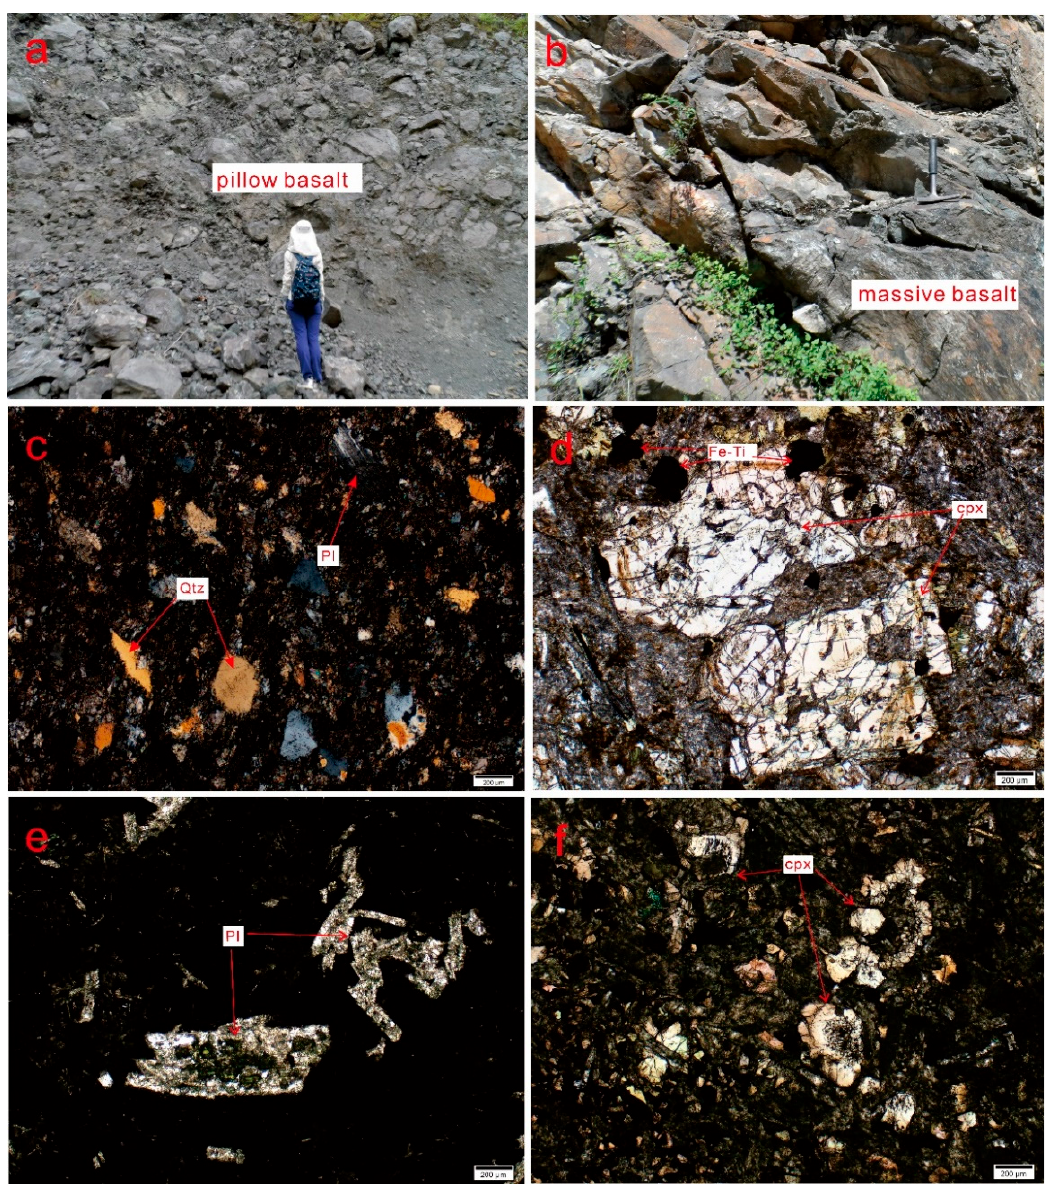
Figure 3. Field and representative photomicrographs of the Dashibao basalt in the Xindianzi area. ( a ) Pillow lavas; ( b ) massive basalt; ( c ) tuff sample containing quartz, feldspar crystal; ( d ) Fe-Ti oxides and clinopyroxene phenocrysts in Group1 basalts; ( e ) plagioclase phenocrysts in Group2 basalt; ( f ) clinopyroxene phenocrysts in Group1 basalt. Pl. plagioclase; Cpx. clinopyroxene; Qtz. quartz; Fe ‐ Ti. Fe ‐ Ti oxides.